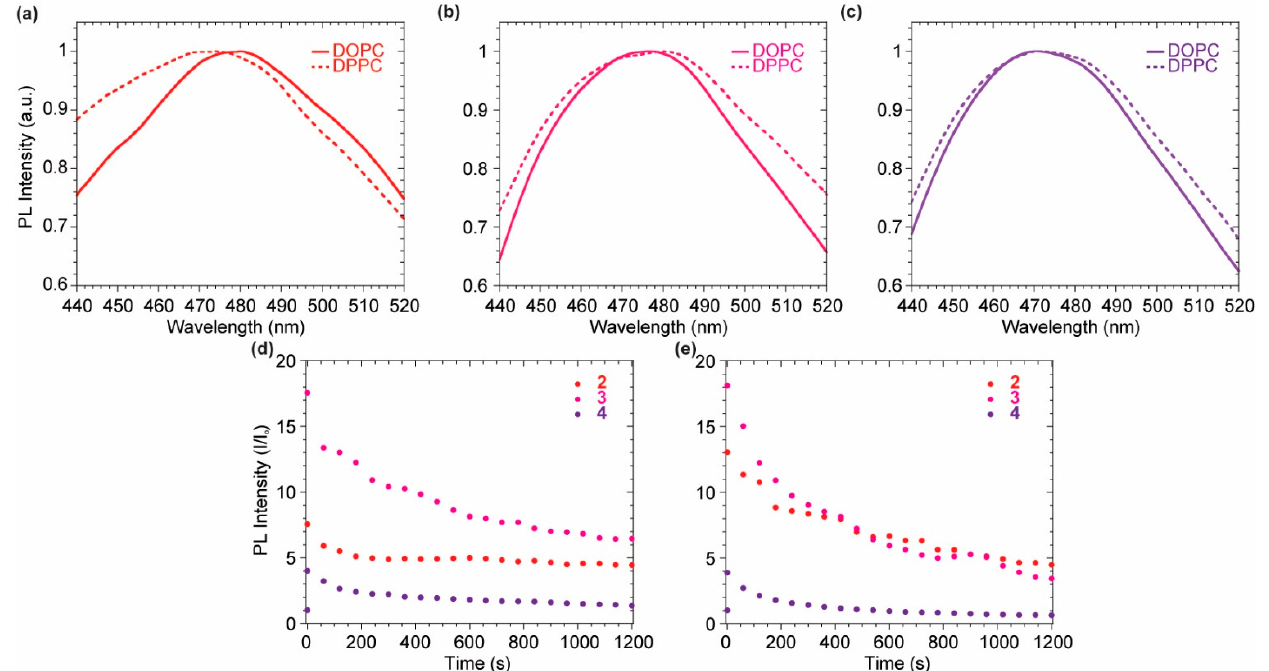
Figure 5. ( a – c ) Normalized emission profile in DOPC (solid line) and DPPC (dashed line) for compounds 2 ( a ), 3 ( b ), 4 ( c ). ( d ) Emission intensity vs. time in DOPC for 2 (red), 3 (magenta), 4 (purple). ( d , e ) Emission intensity vs. time DPPC for 2 (red), 3 (magenta), 4 (purple).